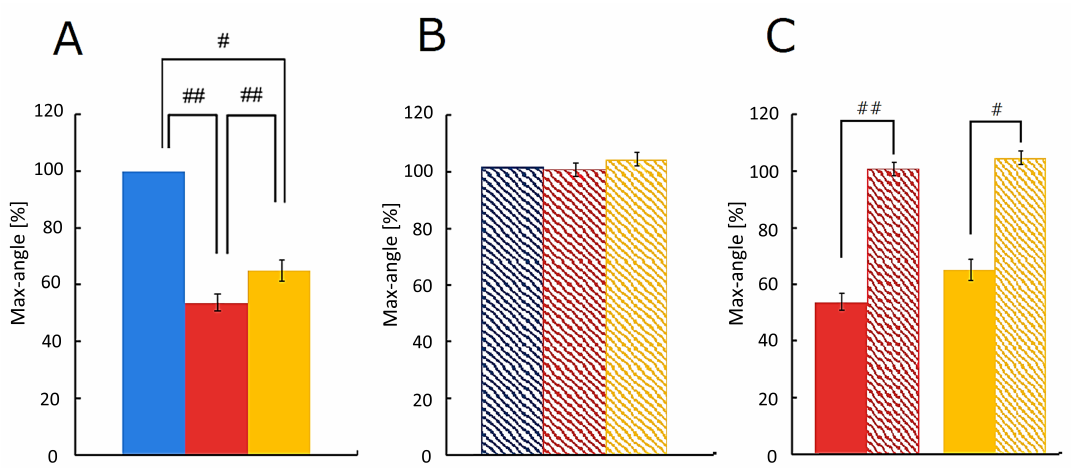
Fig. 8. Comparison of maximum pronation angle. The lesion-induced changes are shown as percentages of the value before the lesion (blue bar). The maximum pronation angle in the lesioned rats (A) is compared before (blue column), 6th days after (red column), and 15th days after (yellow column) the cortical lesion. The data from the sham-operated rats is shown in B. The lesioned rats significantly decreased in the 6th day after and 15th days after the cortical lesion (Tukey-Kramer’s test, # p < 0.05, ## p < 0.01). A comparison between lesioned and sham-operated rats is shown in (C). The sham-operated